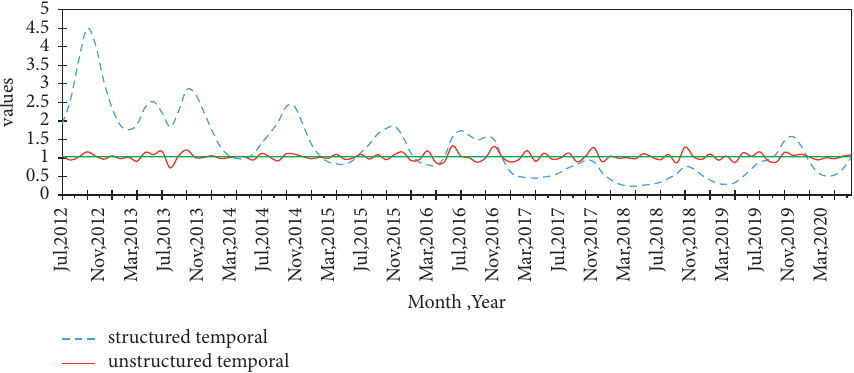
Figure 5: Posterior temporal trends of malaria incidence in the Amhara region, Ethiopia, between 2012 and